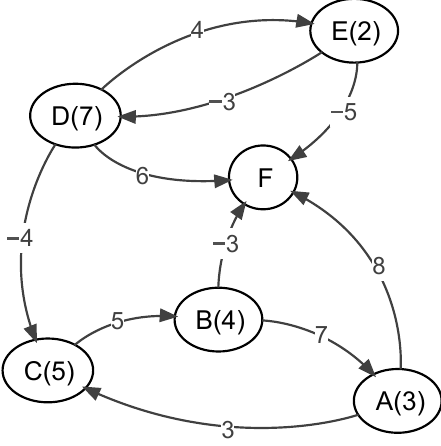
Figure A1. WINGS network for the illustrative